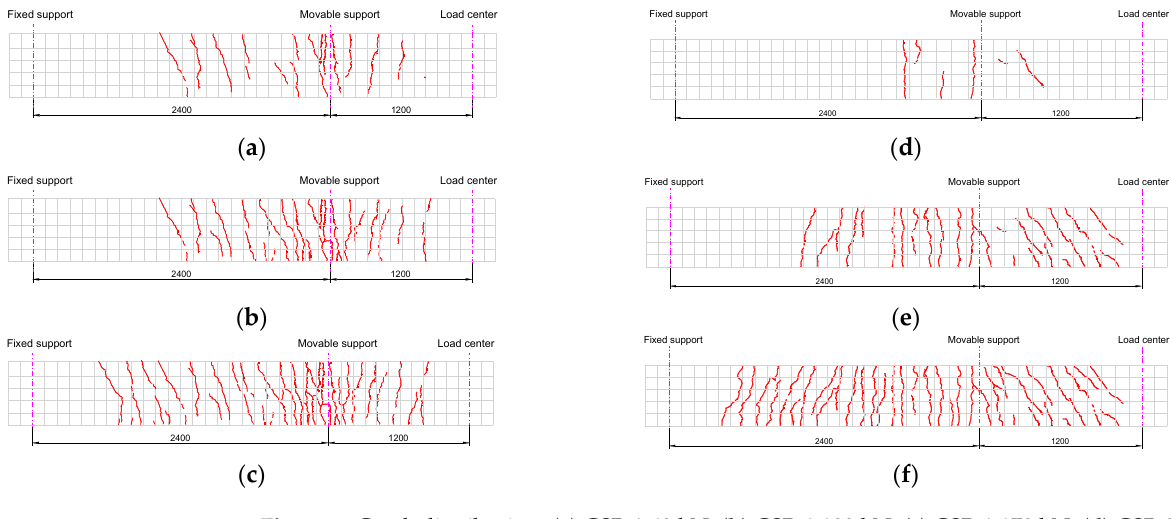
Figure 5. Crack distribution. ( a ) CSB-1 60 kN. ( b ) CSB-1 100 kN. ( c ) CSB-1 170 kN. ( d ) CSB-2 60 kN. ( e ) CSB-2 100 kN. ( f ) CSB-2 170 kN.